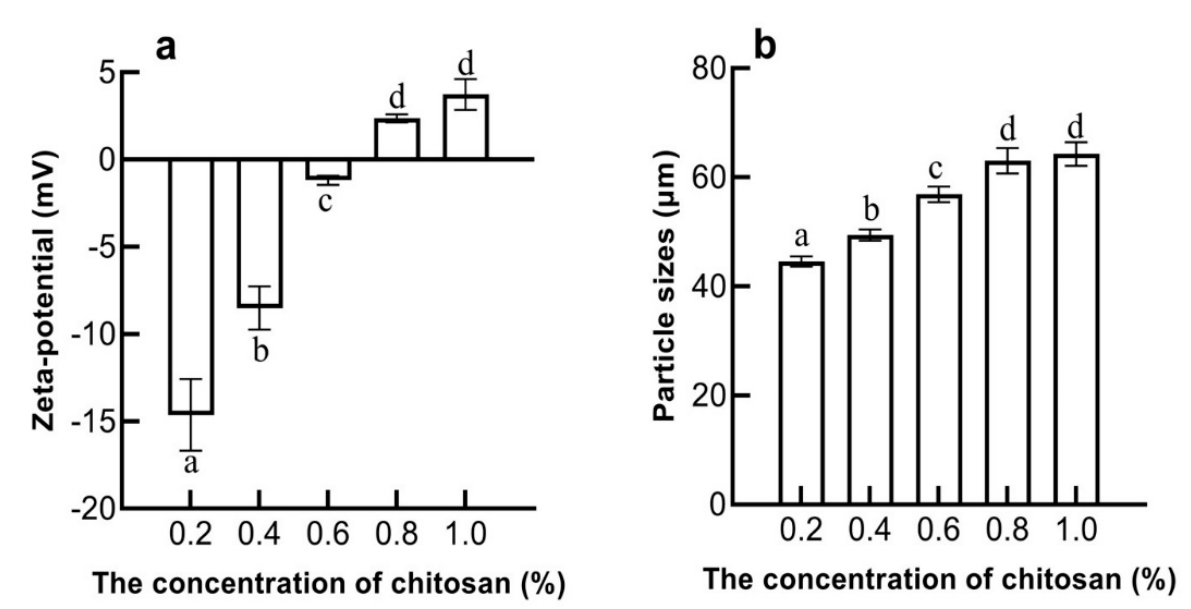
Figure 5. The effect of chitosan concentration on the potential of the double-layer emulsion ( a ). The effect of chitosan concentration on the particle size of the double-layer emulsion ( b ). (Values with different letters are significant at p < 0.05.).